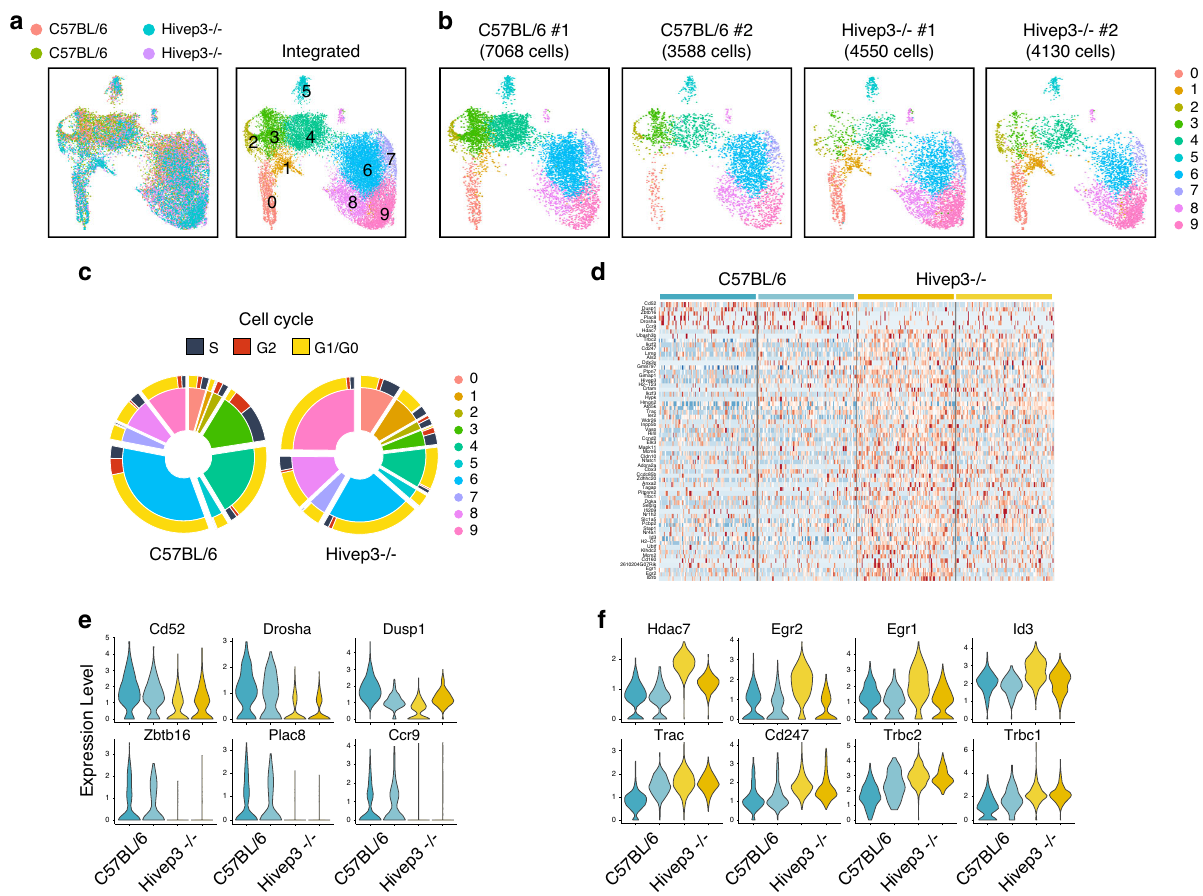
Fig. 5 scRNA-seq analysis of steady-state thymic iNKT cells from Hivep3 − / − mice. a Left , Uniform manifold approximation and projection (UMAP) displaying two independent scRNA-seq data sets from C57BL/6 and two independent Hivep3 − / − thymic iNKT cells colored by sample of origin after MNN batch-correction. Right , UMAP colored by inferred cluster identity for the integrated dataset. b Individual UMAP plots for each biological sample in the dataset, with the sample and number of cells passing quality control and fi ltering indicated above each plot. c Cell cycle scores were computed for each cell in the dataset using the R Seurat package and then categorized into S, G2 or G1/G0 phases. Pie charts depict the proportion of C57BL/6 ( Left ) and Hivep3 − / − ( Right ) cells within each cluster belonging to a given phase of the cell cycle. d Heatmap displaying expression levels of 65 differentially expressed genes across stage 0 iNKT cells in the dataset. The sample to which a given cell belongs are indicated at the top of the heatmap. e , f Violin plots displaying aggregate expression levels per sample of genes that are expressed higher in C57BL/6 ( e ) or higher in Hivep3 − / − ( f ) stage 0 iNKT